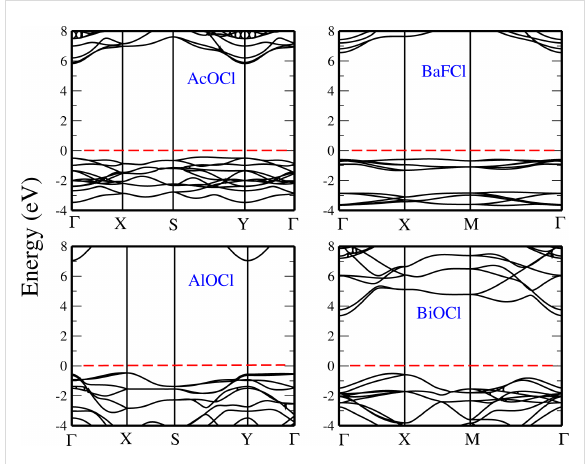
Figure 9: Band structures of the monolayers AcOCl, AlOCl, BaFCl, and BiOCl, using the HSE functional. The Fermi level is set to 0